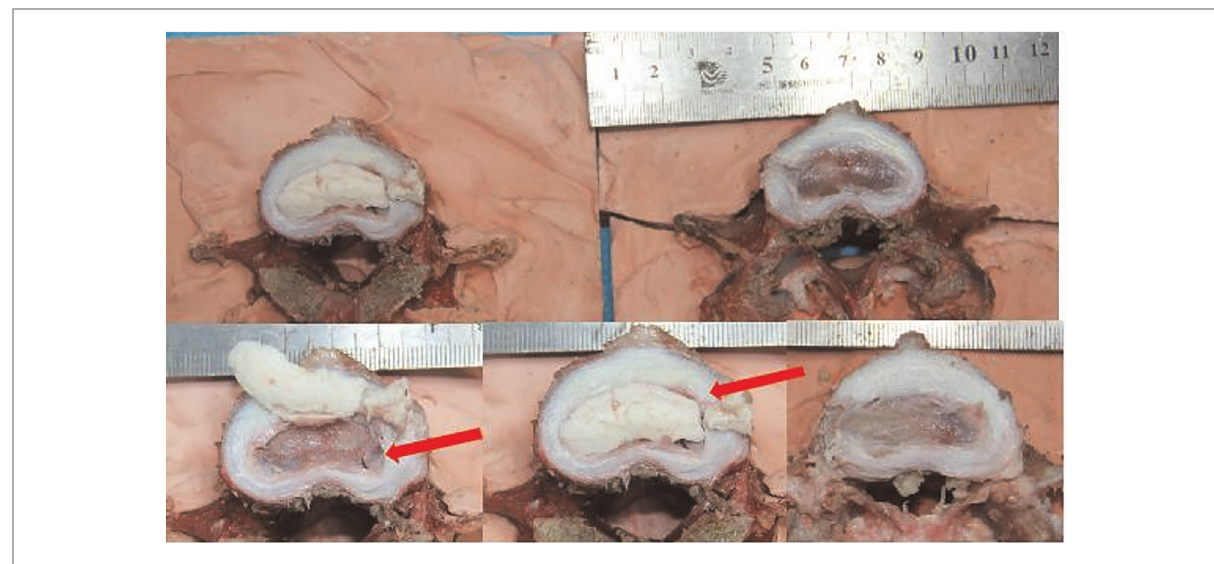
FIGURE 8 Structural changes of specimens subjected to compression failure tests. The red arrow indicates the fracture site of the vertebral body and bone